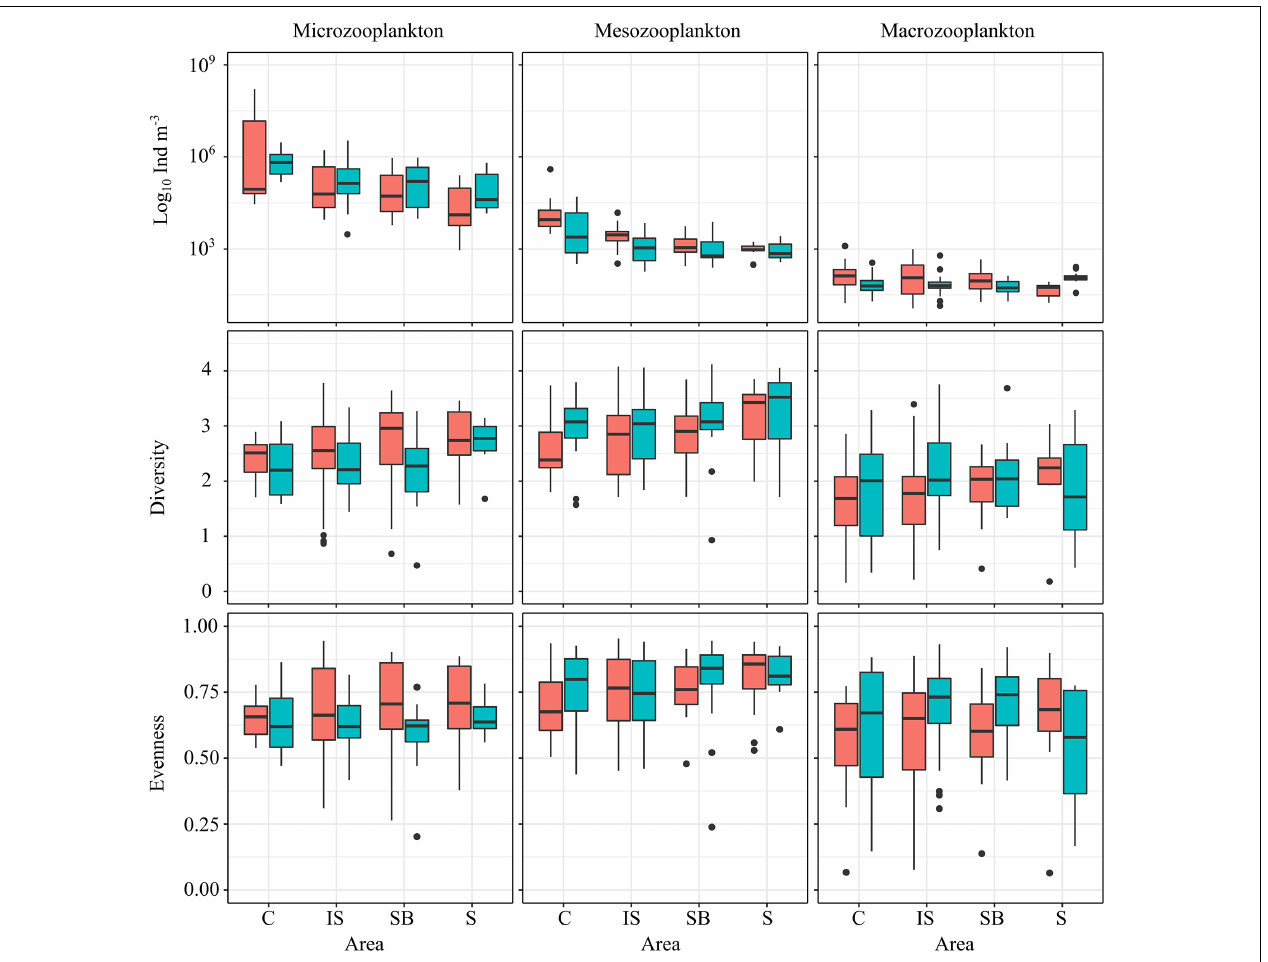
FIGURE 4 | Box-plot of zooplankton density, diversity and evenness at the coastal and oceanic areas off Rio Grande do Norte, Southwestern Atlantic. Dots =